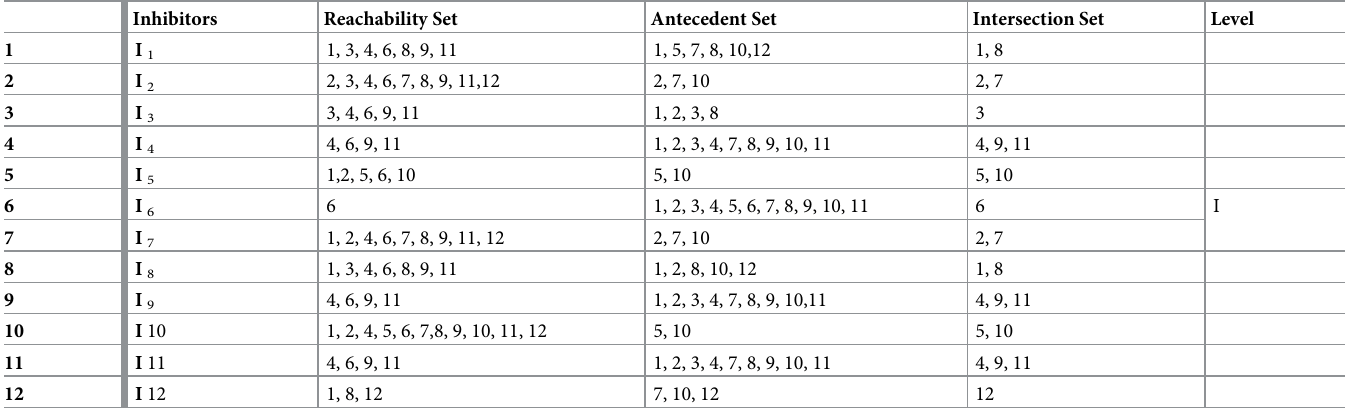
Table 7. Level partitioning iteration -1.